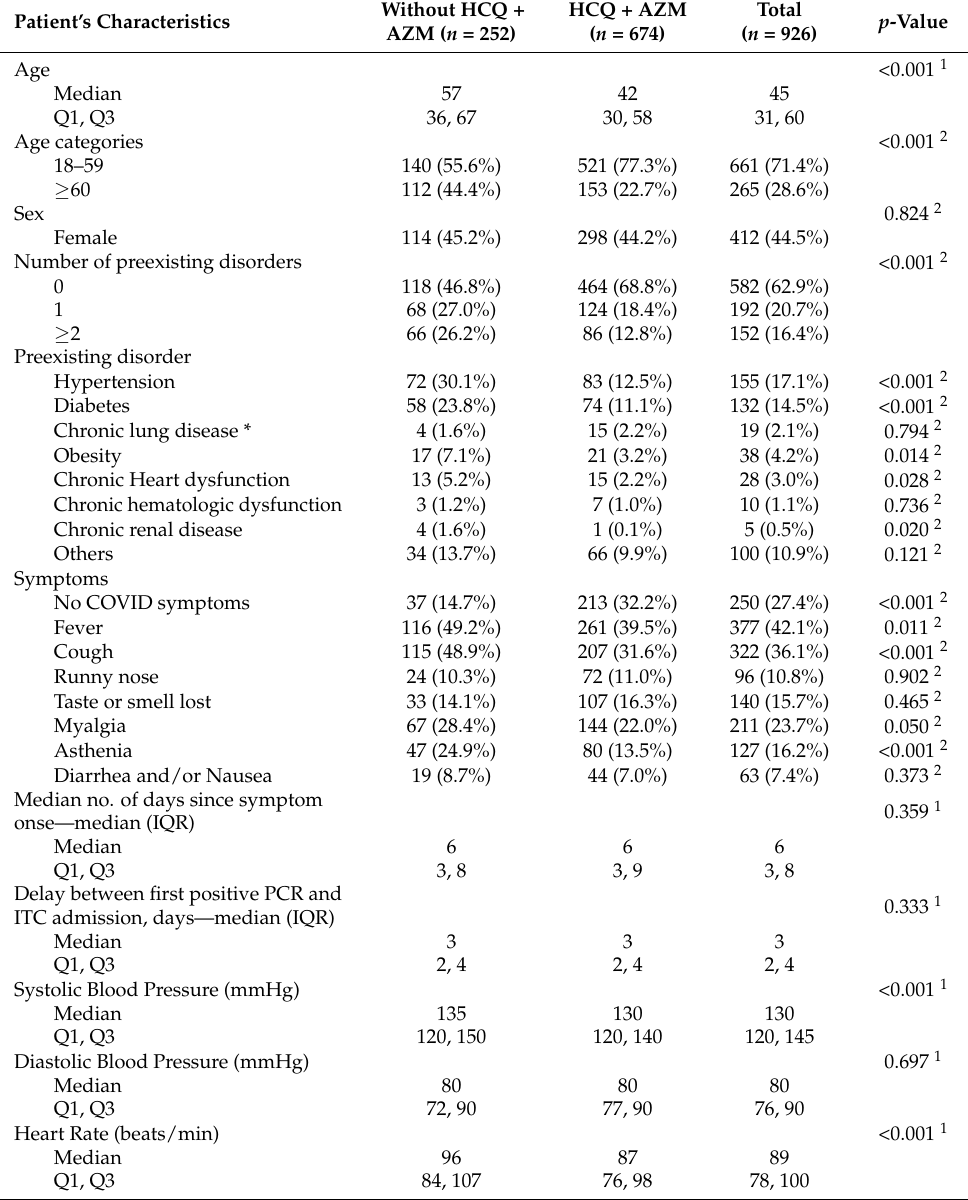
Table 1. Patients’ characteristics at the time of admission in the Isolation and Treatment